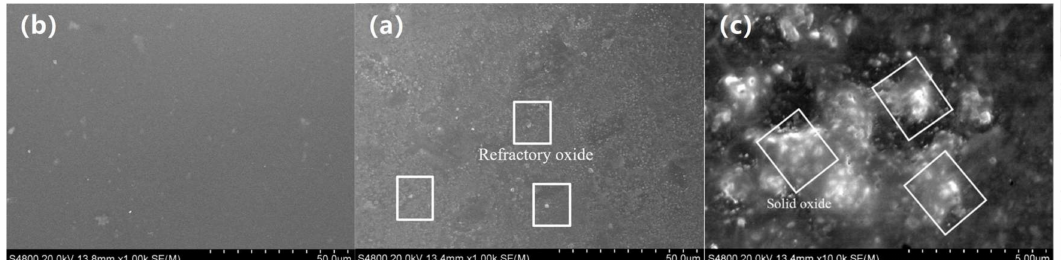
Figure 5. SEM micro-morphologies of the enamel coating sintered at 730 ◦ C for different time. ( a ) is 5 min, ( b ) is 7 min, and ( c ) is 11 min.